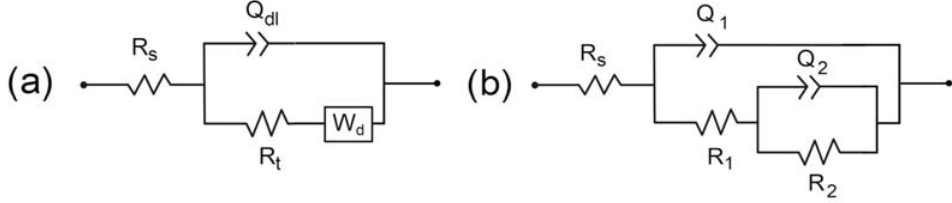
Figure 4. EEC used to fit the EIS data obtained at OCP ( a ) or under CP ( b ) for both coupons.